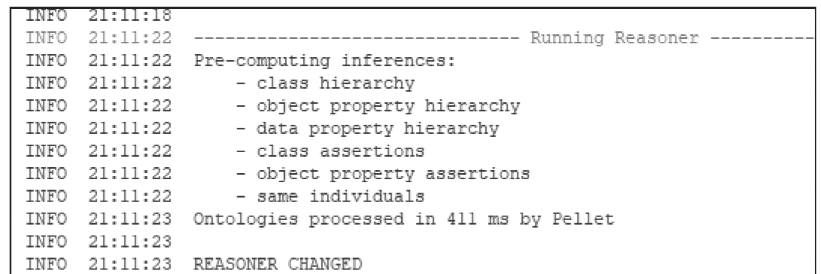
Figure 11: Results of consistency and validity check performed by using Pallet Reasoner.